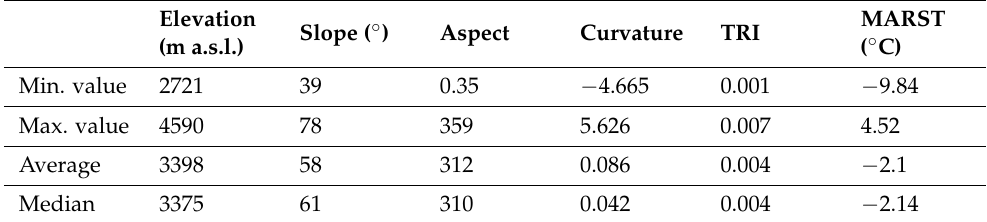
Figure 9. Morphometric characteristics of the IAs in the MBM based on different topographic and topo-climatic parameters: ( a ). elevation, ( b ). slope, ( c ). aspect, ( d ). curvature, ( e ). TRI and ( f ). permafrost. A T refers to the area of the IAs in a particular topo-climatic class, and A MBM is the total area of that class in the MBM. Table 3. Statistical analysis of the IA dataset with different topographic